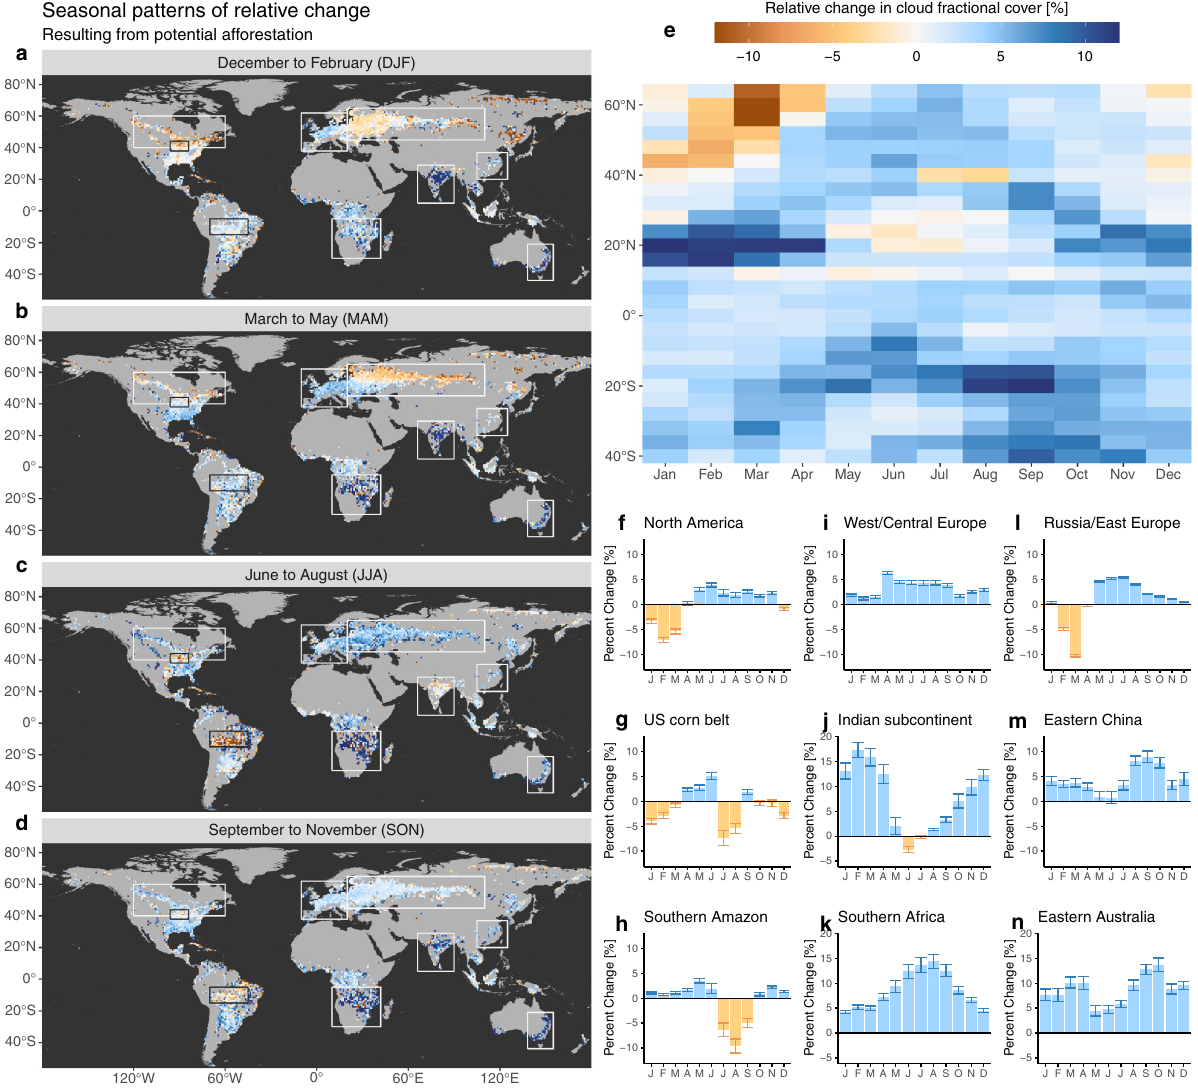
Fig. 1 Changes in cloud fractional cover (CFrC) following potential afforestation as derived from satellite data, expressed in relative terms with respect to the average cloudiness over every grid cell. a – d Maps of seasonal patterns (aggregated to a reduced spatial resolution of 1° for visualization purposes). e Latitudinal averages. f – n Seasonal behaviour of the mean change in CFrC over selected regions, each bar representing a month from January until December. The error bars represent the standard error around the mean. The grey areas in the maps represent places where no estimations are possible due to insuf fi cient coverage of either forests or low vegetation. The same fi gure is available for the absolute changes in CFrC in the Supplementary